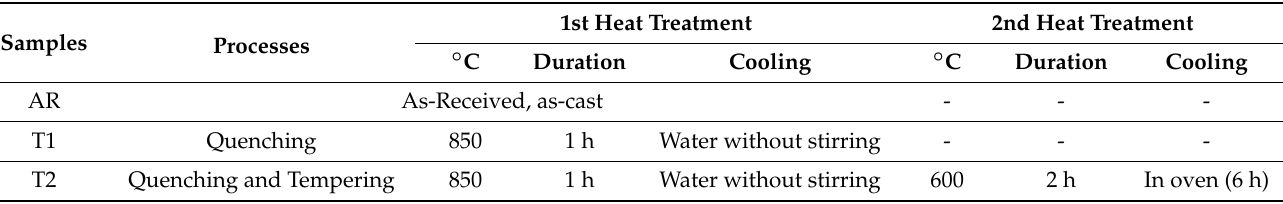
Table 2. List of samples, types, and parameters of heat